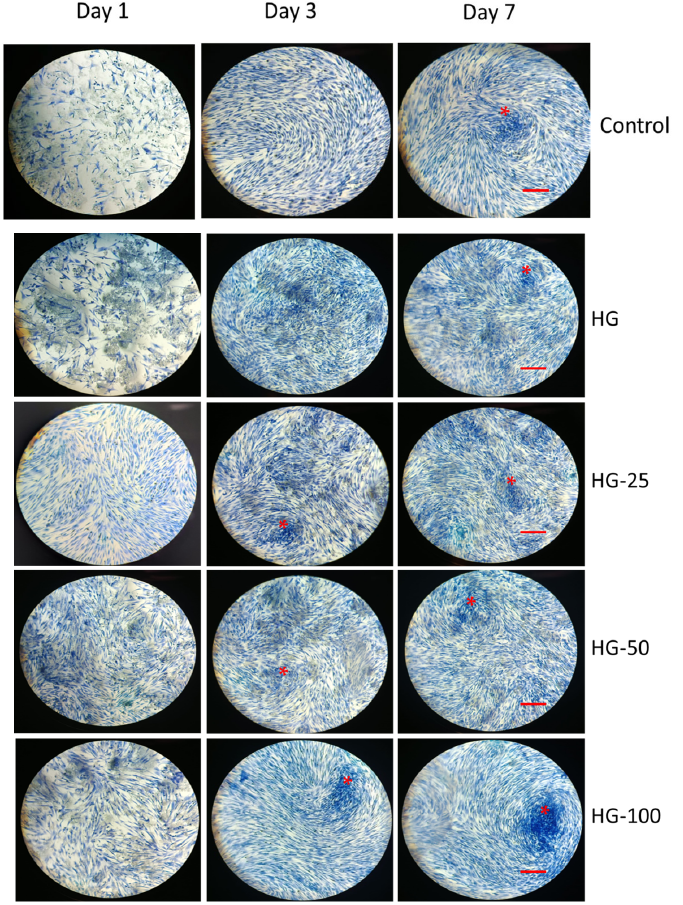
Figure 4. Morphological analysis of MSCs cultured on hydrogels by HE staining. Control—cells without hydrogels, HG—hydrogels without VEGF, HG-25, -50, and -100—hydrogels with 25 ng/mL, 50 ng/mL, and 100 ng/mL of VEGF, respectively. Scale bar 10 × —100 µ m. The asterisk indicates cellular aggregation and matrix